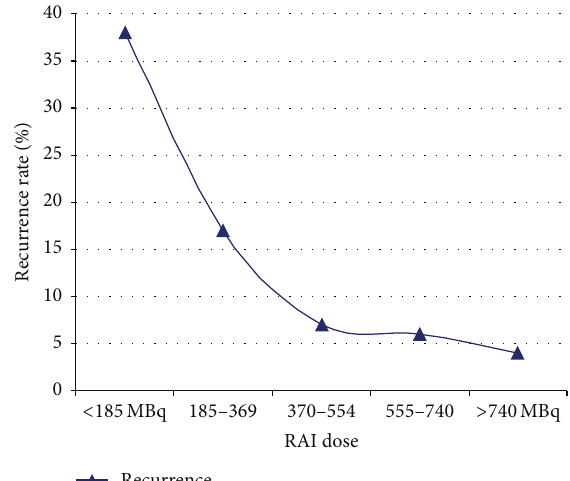
Figure 4: Recurrence rate in relation to RAI